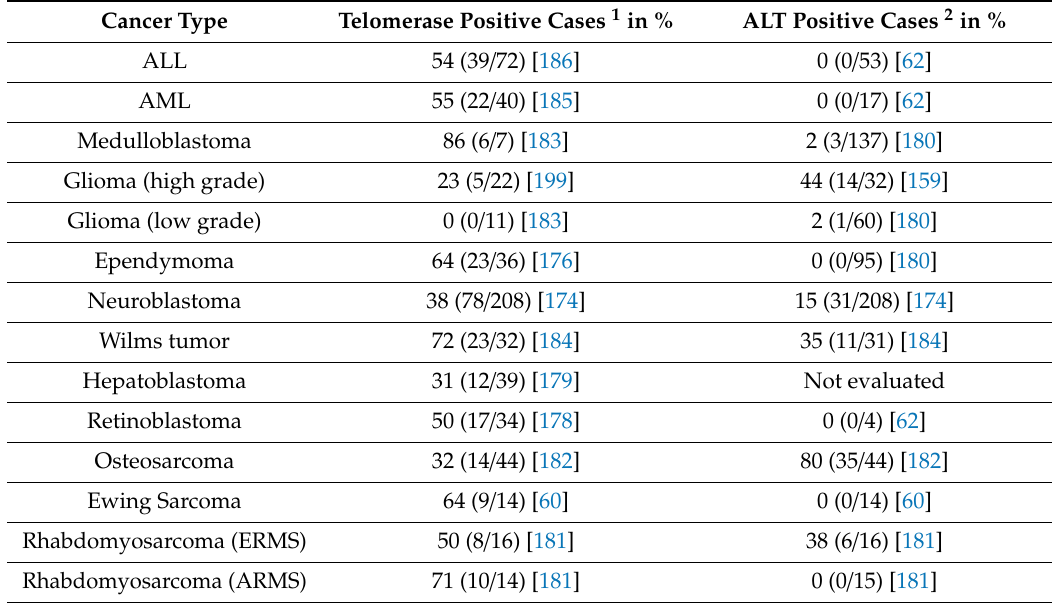
Table 1. Telomere biology in pediatric